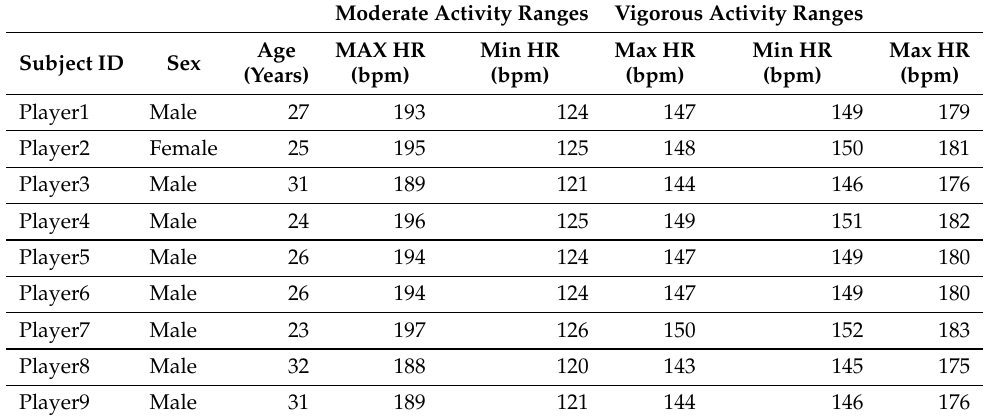
Table 3. Preprocessing of PAMAP2 data [25,26]: max HR, moderate and vigorous activity